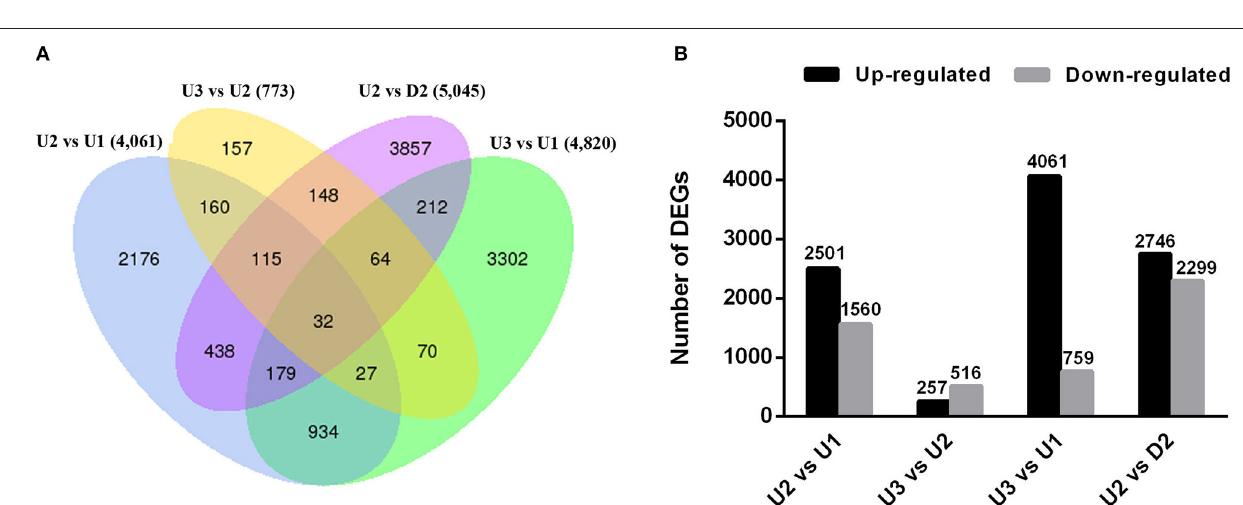
FIGURE 2 | qRT-PCR validation of differential gene expression in U1, U2, U3, and D2. The left y-axis indicates relative gene expression levels. The right y-axis indicates gene expression levels calculated based on mean FPKM value of each sample.